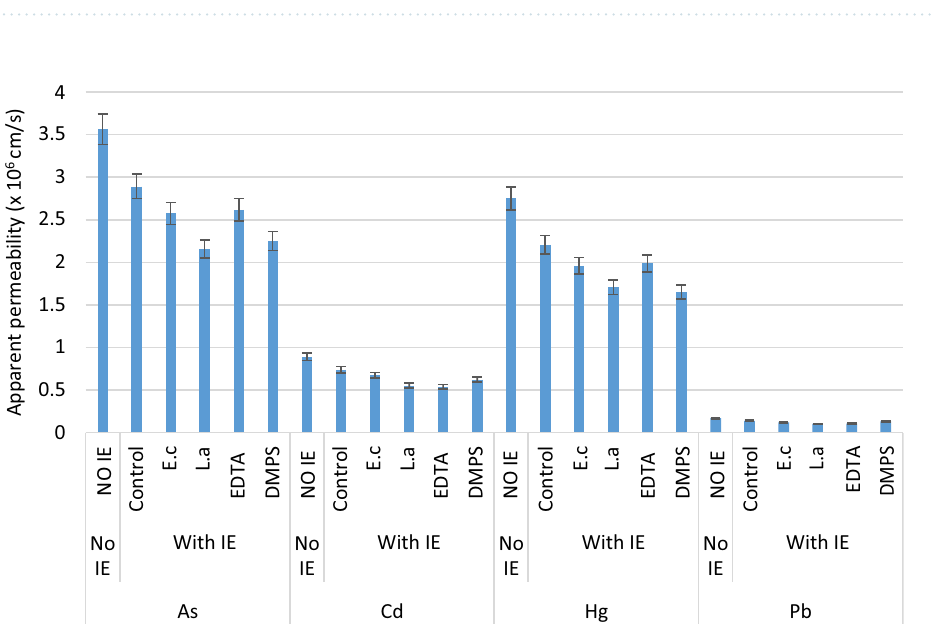
Figure 4. Effect of gut bacteria and chelating agents on the intestinal permeability of As, Cd, Hg and Pb. IE, intestinal extract; EDTA, ethylenediaminetetraacetic acid; DMPS, 2,3-dimercaptopropane-1-sulfonate; E.c , Escherichia coli ; L.a , Lactobacillus